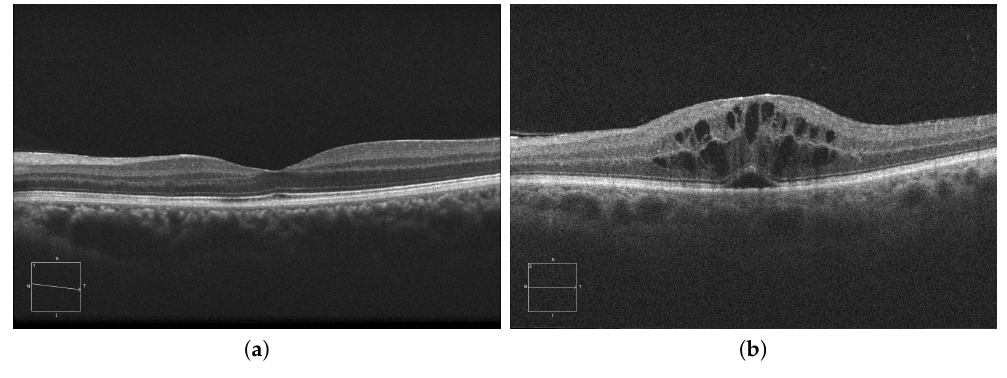
Figure 1. Macular Optical Coherence Tomography (OCT) images. ( a ) OCT without the presence of cystoid regions. ( b ) OCT with the presence of cystoid